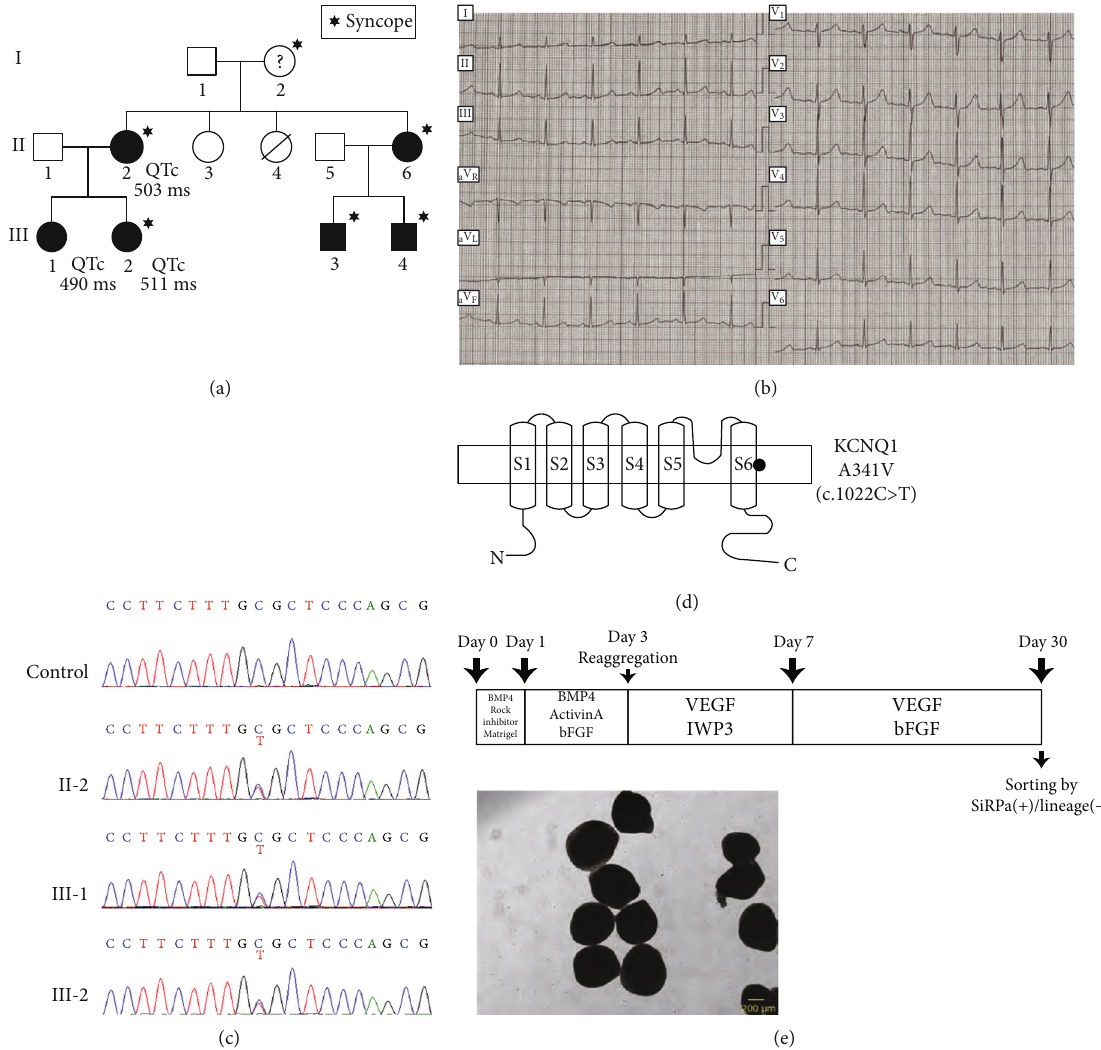
Figure 1: Type 1 long QT syndrome family background and cardiac di ff erentiation from human iPSCs. (a) Family pedigree. The squares indicate males, and the circles indicate females. Closed symbols mark patients con fi rmed by their DNA sequences. Hexagrams mark members who have a syncope history. The QTc values of three patients before taking a beta-blocker are stated. (b) ECG of II-2 in (a) before the patient started taking a beta-blocker. (c) Sanger sequencing of the three patients and one control. (d) Schematic fi gure of KCNQ1 protein. The black circle indicates the mutation site within the transmembrane region. The lower side locates intracellular. (e) Outline of the cardiac di ff erentiation. Lower: representative shapes of beating EBs. Scale bar: 200 μ